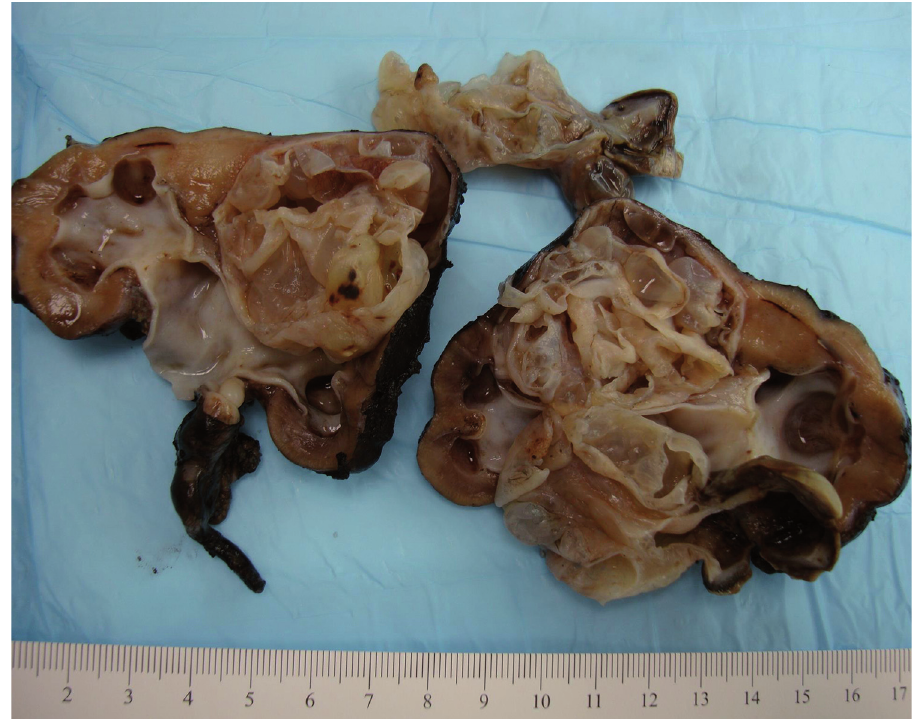
Figure 1. Macroscopic examination of bilateral CN of a 5-month-old male. Image provided by Professor Ellen M. Chung and Director Donald E. Hatley